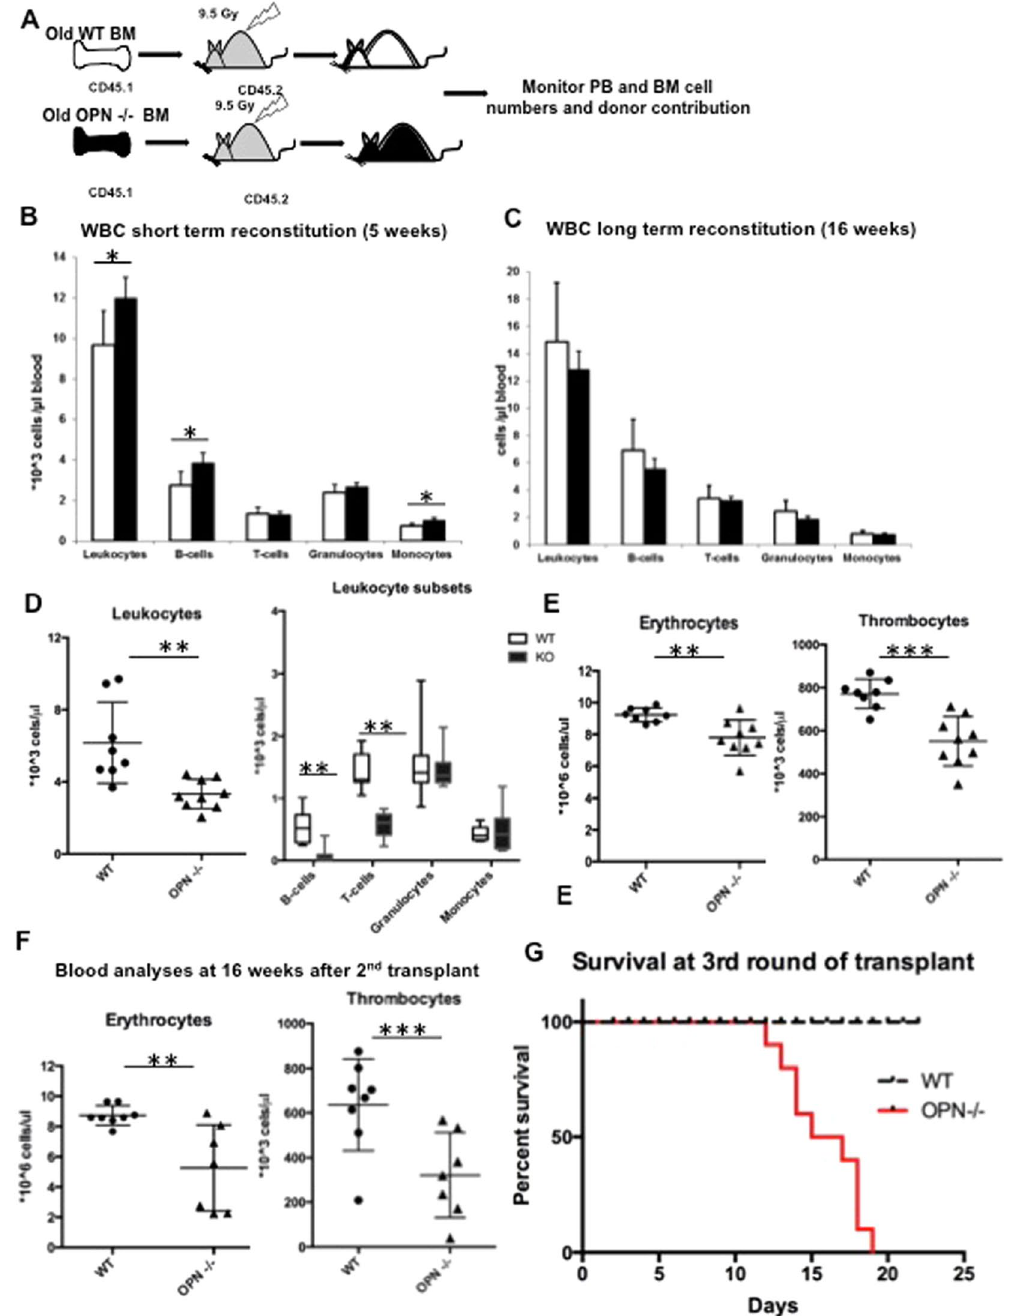
Figure 3. OPN deficiency results in loss of serial reconstitution ability in aged animals. ( A ) Schematic of the transplantation and analysis setting. Bone marrow from CD45.1-bearing WT or OPN-KO mice was transplanted into lethally irradiated CD45.2-bearing recipients and monitored for peripheral blood and bone marrow reconstitution. ( B ) Short- and ( C ) long-term analysis of peripheral blood cells at 5 and 16 weeks after transplantation. ( D ) Total leukocyte count and leukocyte subsets from a secondary bone marrow transplant. ( E ) Red blood cell and platelet counts in the secondary recipients of aged OPN − / − and WT bone marrow 10 weeks after bone marrow transplant. ( F ) Analysis of blood cell counts of the same mice 16 weeks after the second round of bone marrow transplant. ( G ) Kaplan Meier plot indicating survival after third round of bone marrow transplant. Values are the mean ± SD, n ≥ 7, * P < 0.05, ** P < 0.01, *** P <